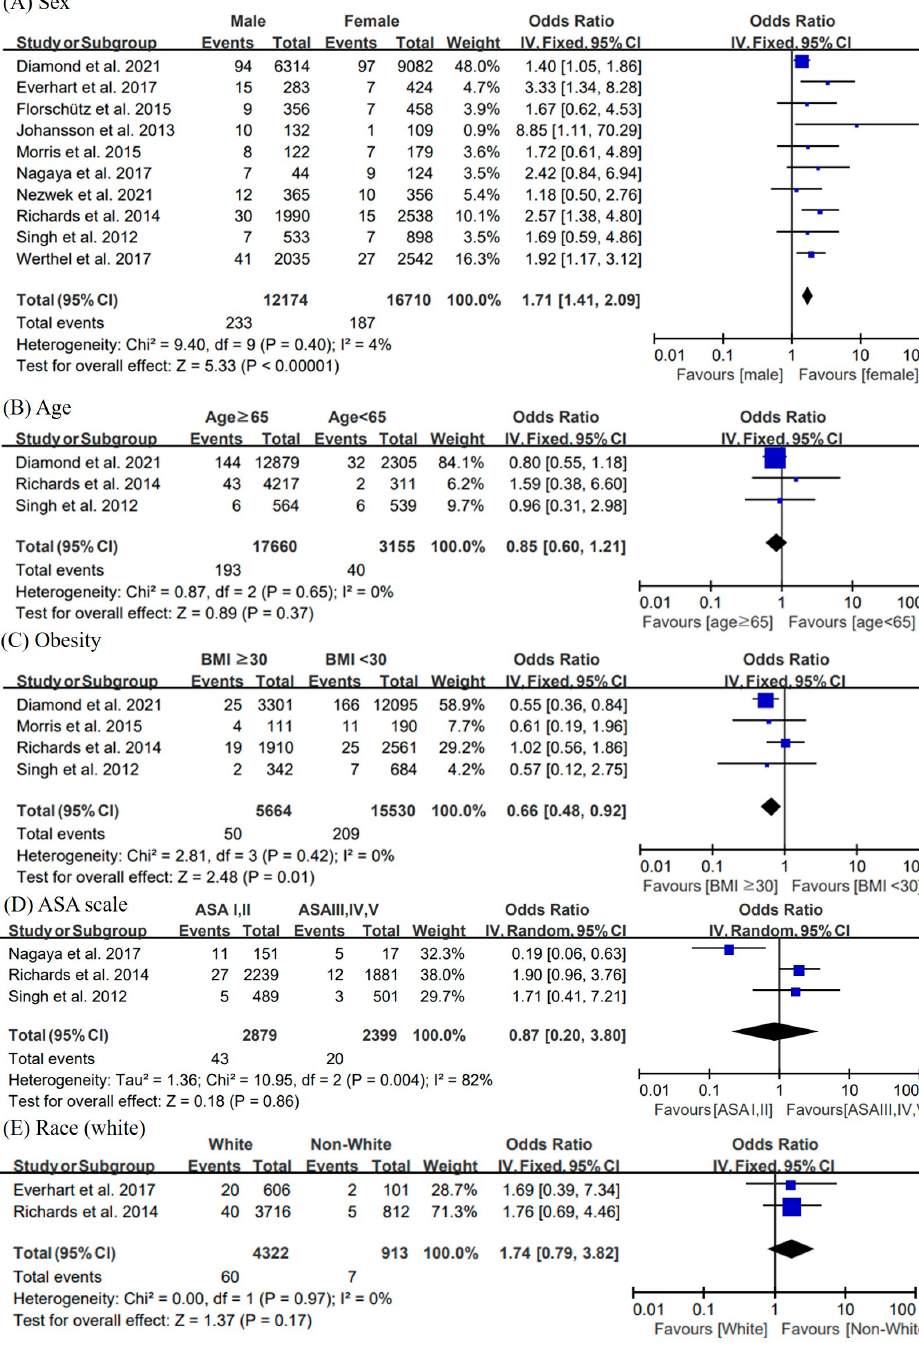
Figure 2. Forest plots, pooled odds ratio, 95% confidence interval, and heterogeneity for demographic factors. The risk factors analyzed in the demographic subgroups include ( A ) male (vs. female), ( B ) age ( ≥ 65 years old) ( C ) obesity (BMI ≥ 30), ( D ) ASA scale I, II versus III, IV, V), and ( E ) white race versus non-white races. BMI, body mass index; ASA, American Society of Anesthesiologists